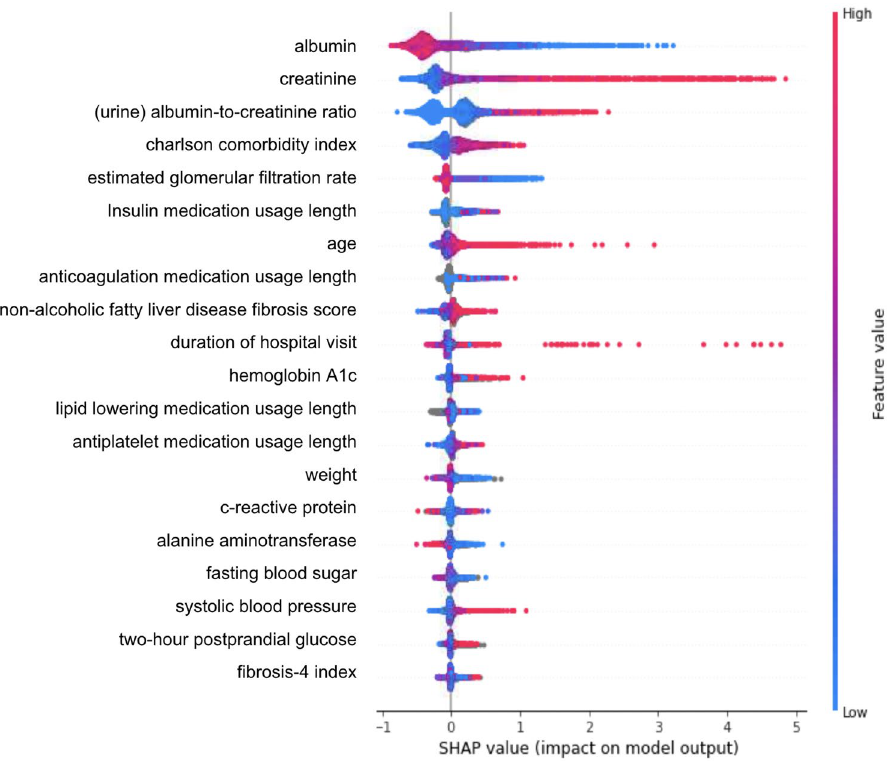
Figure 3. SHAP summary plot. If a feature is located on the upper side of this figure, then it implies a higher contribution of the feature to the prediction. More specifically, each dot represents the data of each patient, and the color of the dot indicates whether the respective feature value is low or high (as shown on the y-axis on the right). The location of the dot indicates whether the feature increases (right) or decreases (left) the risk prediction. The farther a dot is from 0, the greater the contribution to the prediction. SHAP Shapley Additive